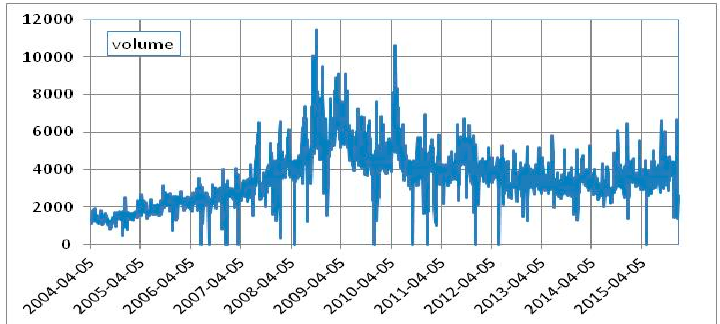
Figure 1. Evolution over time of the daily trading volume of the NYSE (New York Stock Exchange) Composite US 100 between 5 April 2004 and 31 December 2015.